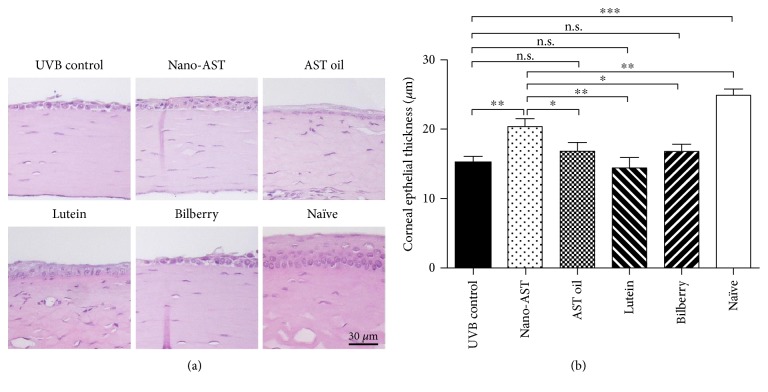
Comparison of protective effect of nano-AST, AST oil, lutein, and bilberry extract. (a) Morphological analysis of murine corneal tissue using H&E staining. Noticeable thinning and morphological and structural changes in epithelial cell layer with increased cellular infiltration of corneal stroma were observed in the UVB control, AST oil-, lutein-, and bilberry-treated groups. While thickness of corneal epithelial layer in nano-AST-treated animals was obviously thinner compared to naïve nonirradiated corneas, cellular morphology and epithelial layer structure are well preserved. Scale bar: 30 μm. (b) Nano-AST (50 mg/kg) treatment resulted in significant thicker corneal epithelium compared to the UVB controls (p < 0.01), AST oil (p < 0.05), lutein (p < 0.01), and bilberry extract (p < 0.05) treatment. n = 8 (eyes) per group. n.s., p > 0.05; ∗p < 0.05; ∗∗p < 0.01; ∗∗∗p < 0.001.